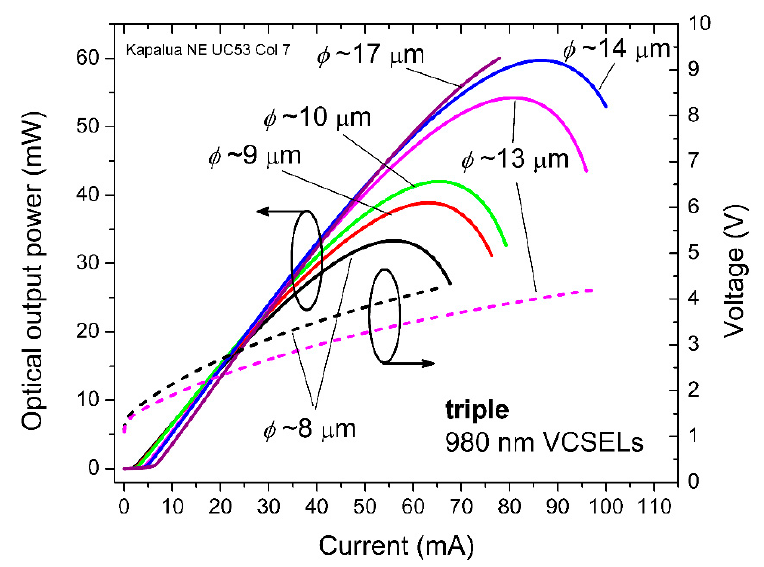
Figure 3. Measured static optical output power and voltage as functions of applied direct current (DC) bias current for 980 nm triple VCSEL arrays with oxide aperture diameters ( ϕ ) from ~8 to 17 μ m.